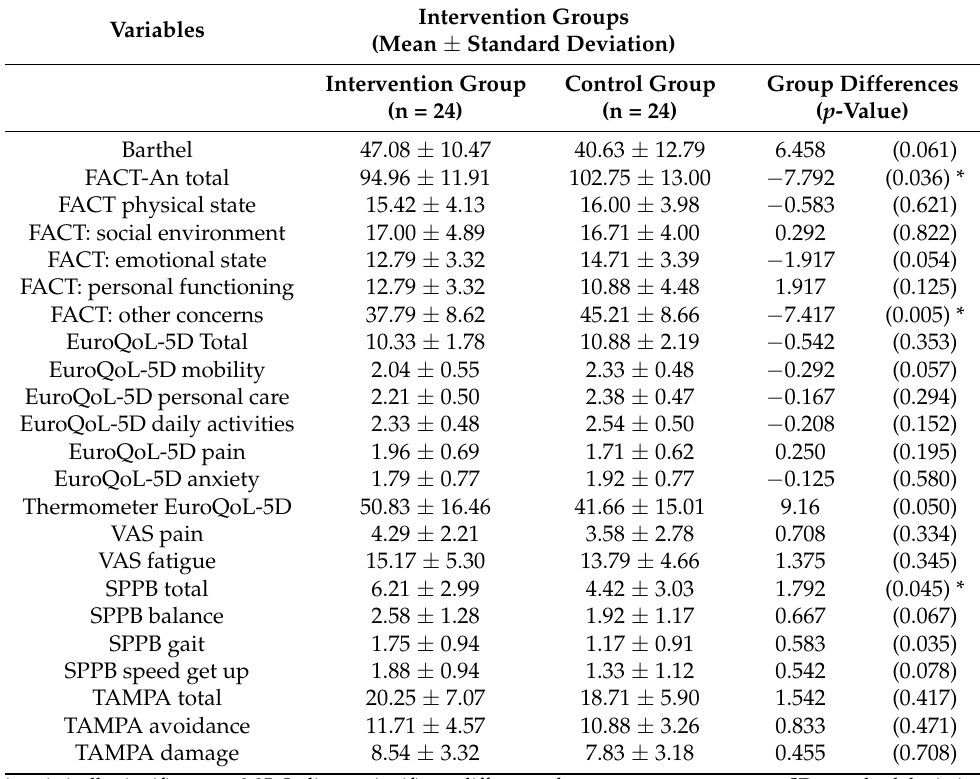
Table 2. Outcome parameters at baseline evaluation and differences between